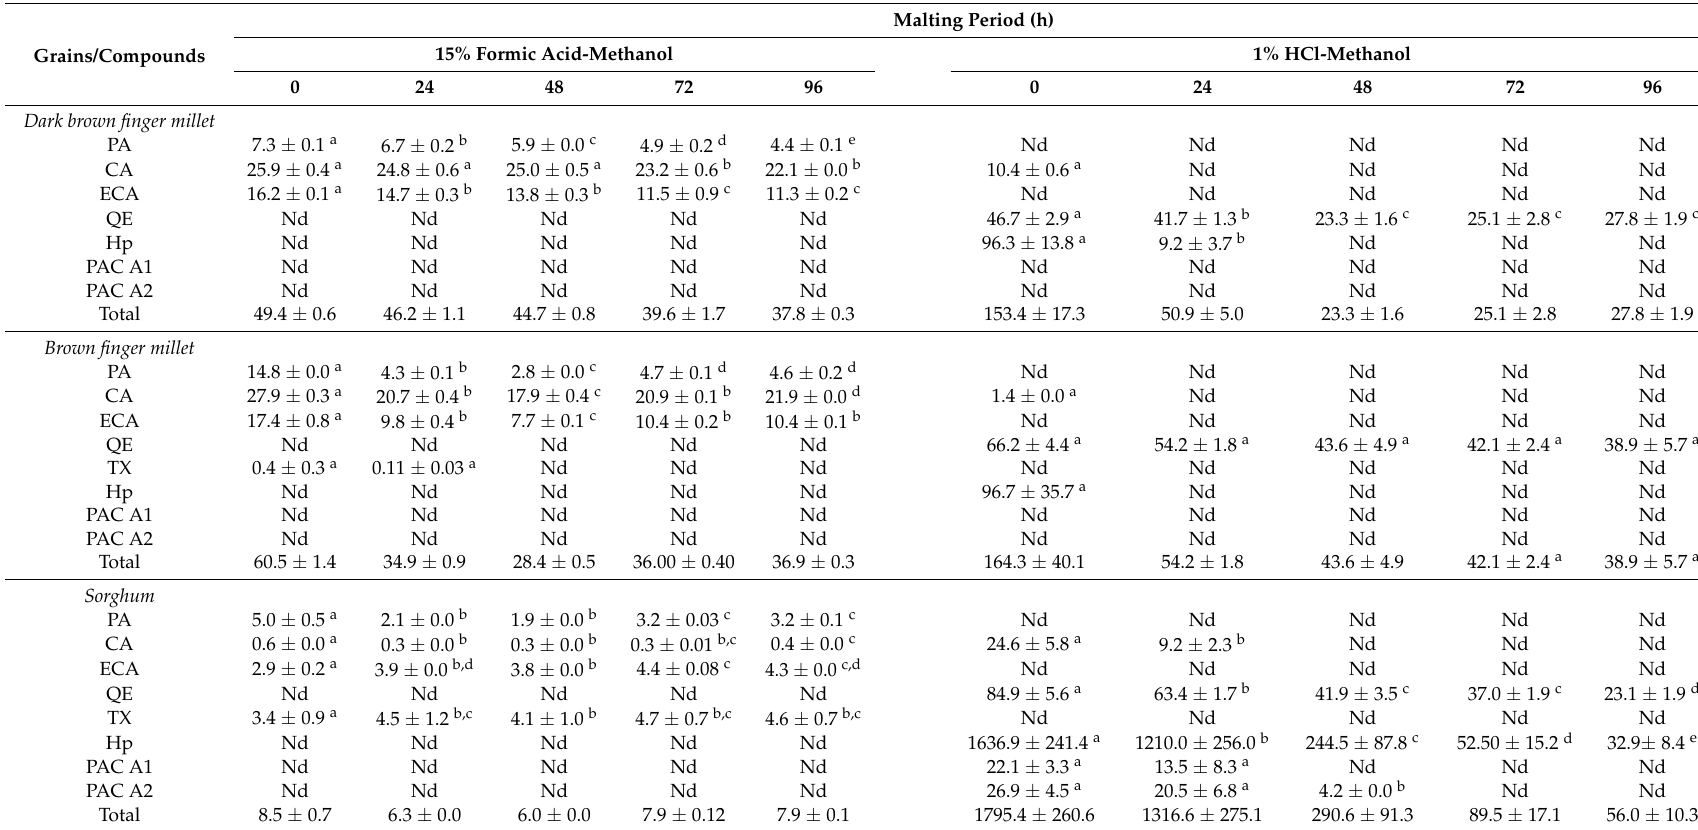
Table 2. Changes in contents ( µ g/g) of phenolic compounds in formic acid and HCl-methanol extracts of the cereal grain